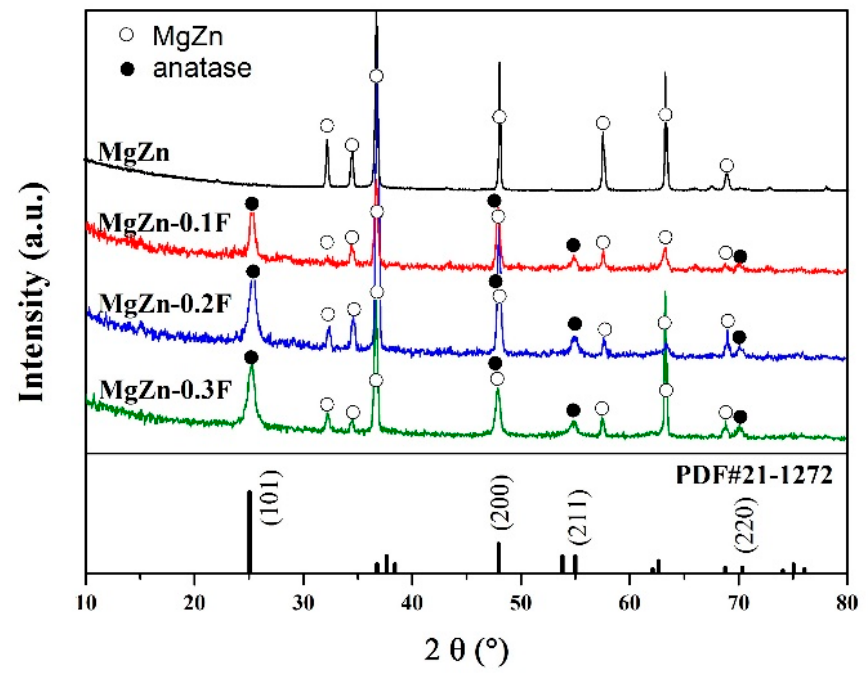
Figure 2. XRD patterns of the as-prepared anatase coatings.